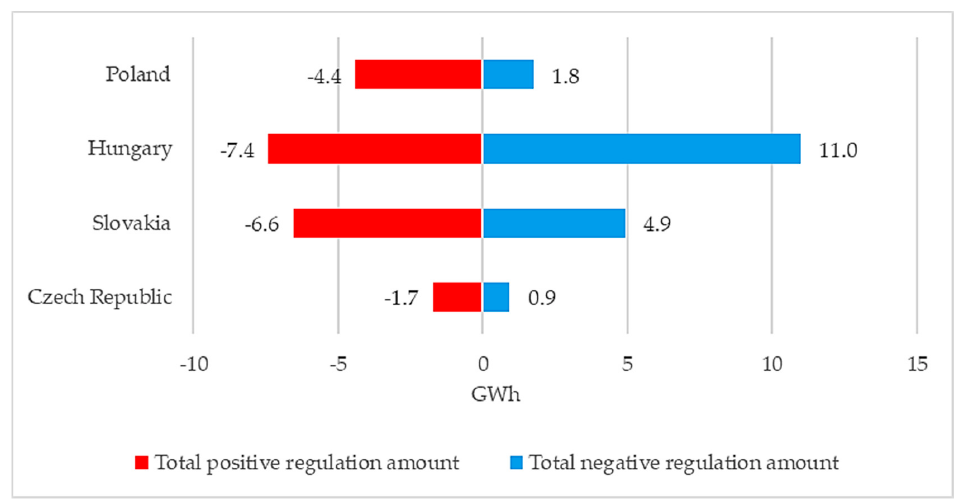
Figure 3. The total regulation amounts in the Visegrad countries necessary for 100 MWp PV systems in the period of 1 September 2019 to 31 August 2020.